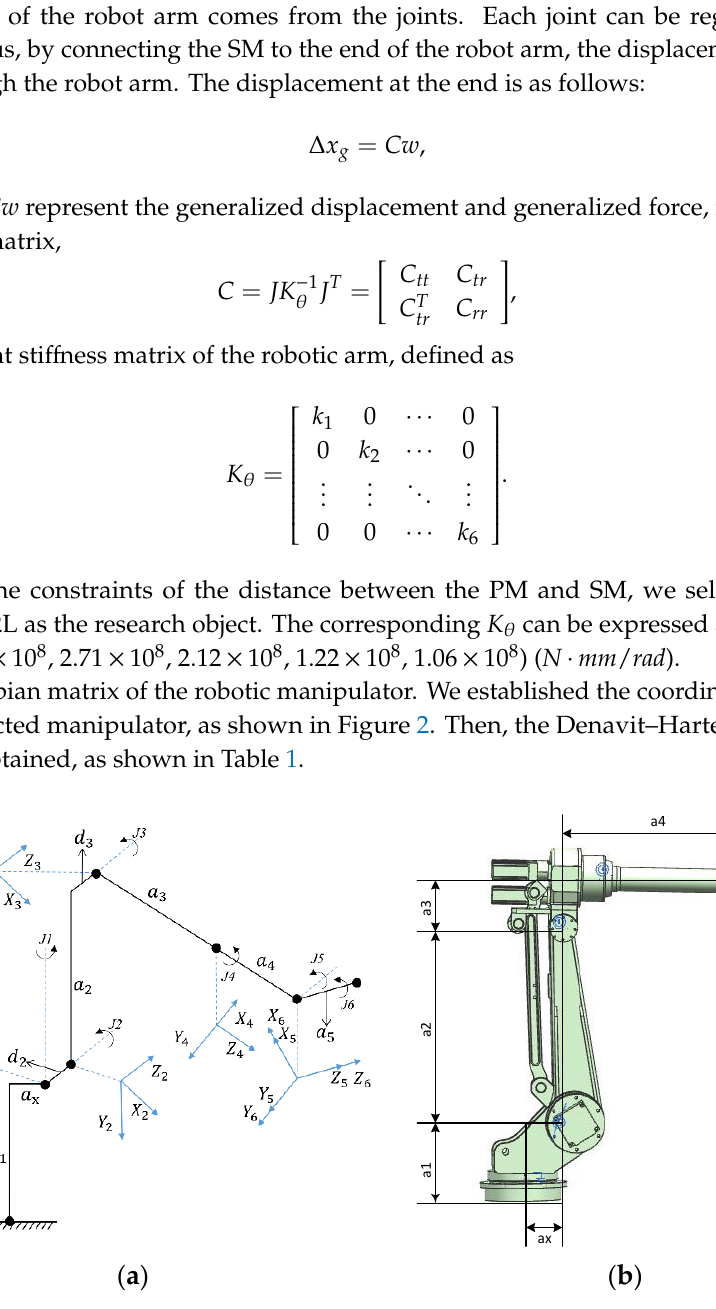
Figure 2. Kinematics model. ( a ) The coordinate system establishment. ( b ) The Kinematic parameters.